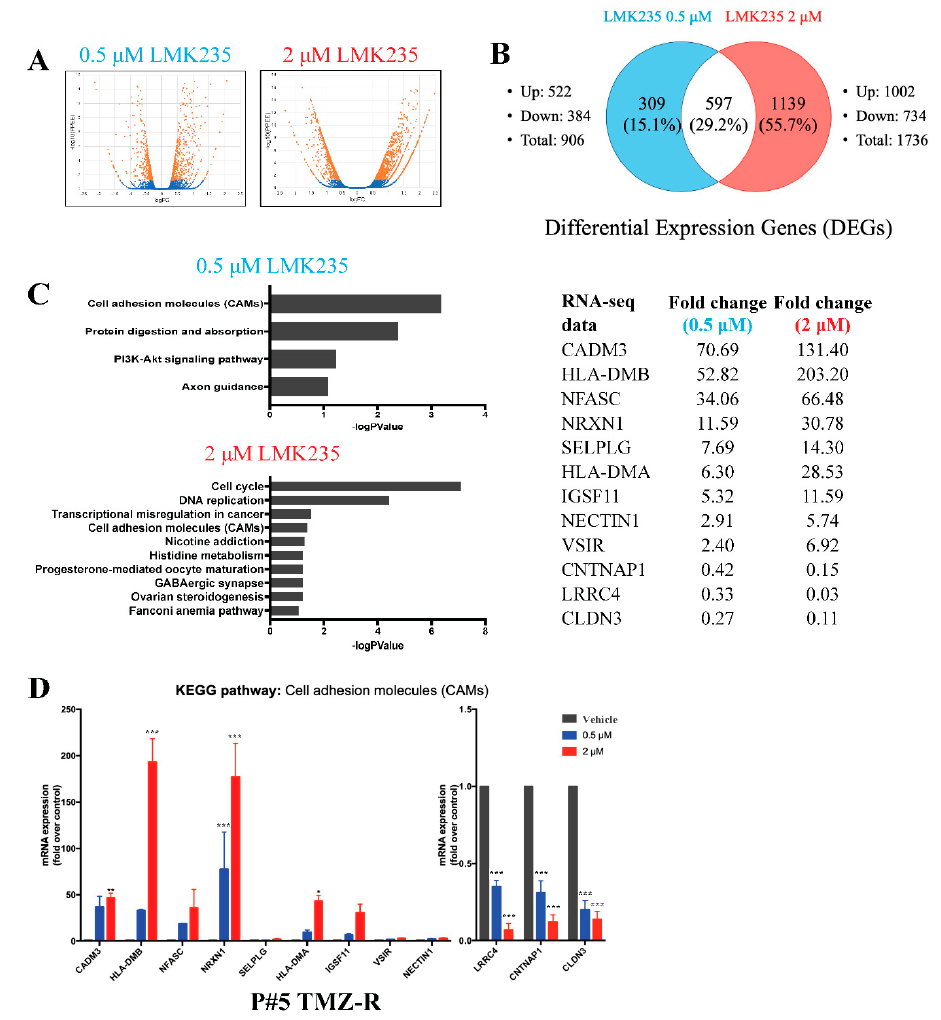
Figure 3. RNA-seq analysis after LMK235 treatment. Volcano plot ( A ) and Venn diagram ( B ) of DEGs in P#5 TMZ-R cells treated with 0.5 µM or 2 µM LMK235 for 72 h. ( C ) KEGG pathway analysis of the DEGs in the 0.5 µM and 2 µM LMK235-treated groups. The –logP value of the pathway in each group was ranked from highest to lowest. DEGs in the “cell adhesion molecules (CAMs)” path- way after LMK235 treatment were listed. ( D ) The mRNA expression levels of the DEGs mentioned above were verified by qPCR. * indicates comparison with vehicle; mean ± SEM. * p < 0.05, ** p < 0.01, *** p < 0.001.